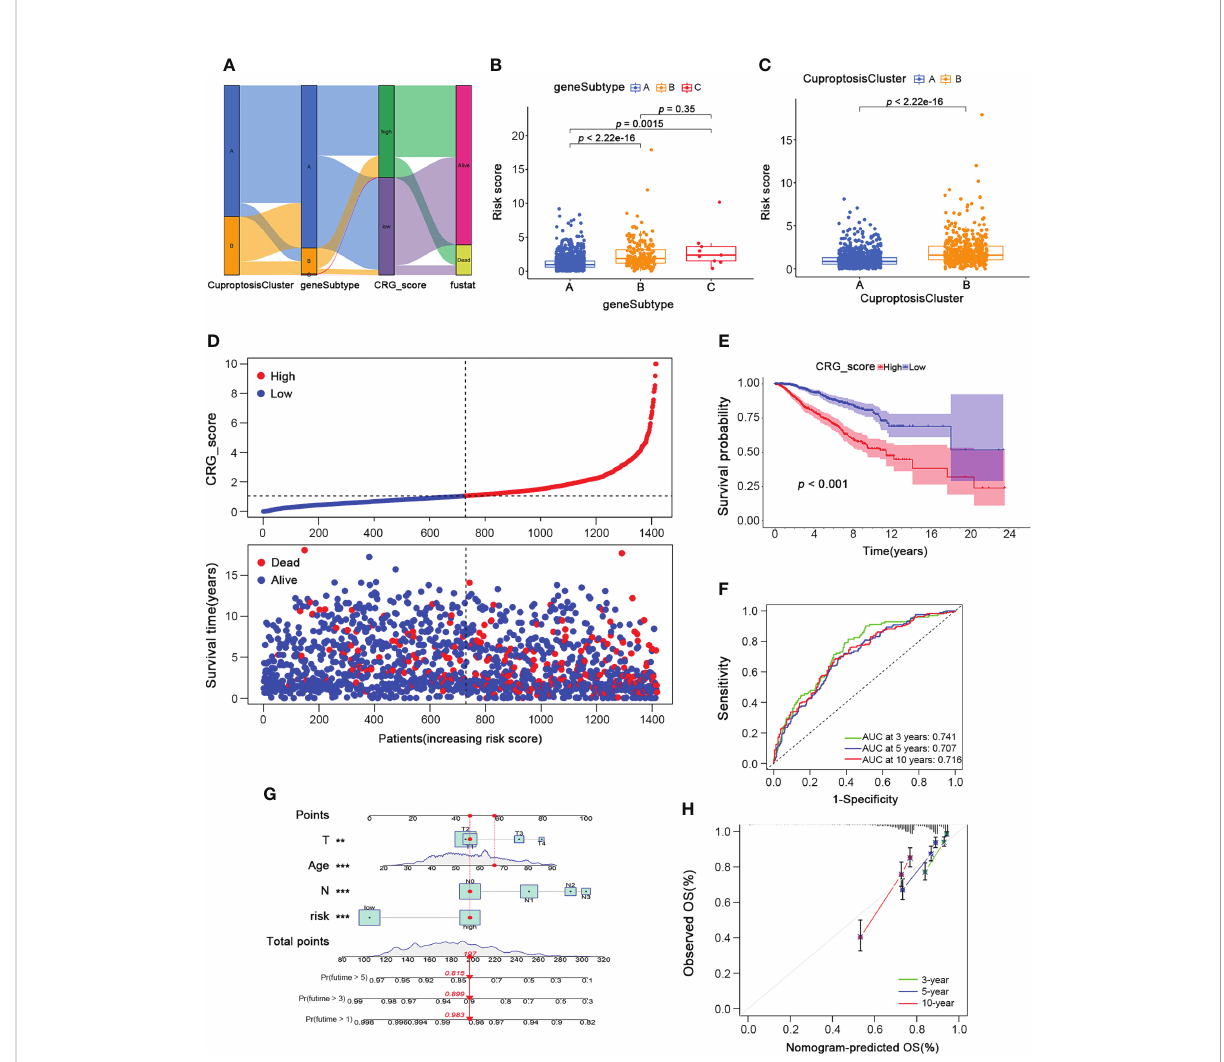
FIGURE 6 Development of the Cuproptosis-Related Gene Signature and CRG_score in the BRCA Training cohort. (A) The alluvial diagram showing the connection between CuproptosisClusters, gene subtypes, and CRG_score. (B) The level of CRG_score in the three gene subtypes (Wilcoxon test). (C) The level of CRG_score in the two CuproptosisClusters (Wilcoxon test). (D) The ranked dot and scatter plots of CRG_score distribution and patient survival status in BRCA training cohort. (E) The overall survival of the high and low CRG_score groups in BRCA training cohort (Log- rank test). (F) The ROC curves for the predictive ef fi ciency of the CRG_score in BRCA training cohort (green: 3 year; blue: 5 year; red: 10 year). (G) The Nomogram to predict 3-, 5- and 10-year OS in the BRCA training cohort. (H) The Calibration plots of the nomogram to predict OS at 3- , 5- and 10-year (green: 3 year; blue: 5 year; red: 10 year). CRG_score, Cuproptosis-Related Gene Score; ROC, receiver operating characteristic. * p < 0.05, ** p < 0.01, *** p <